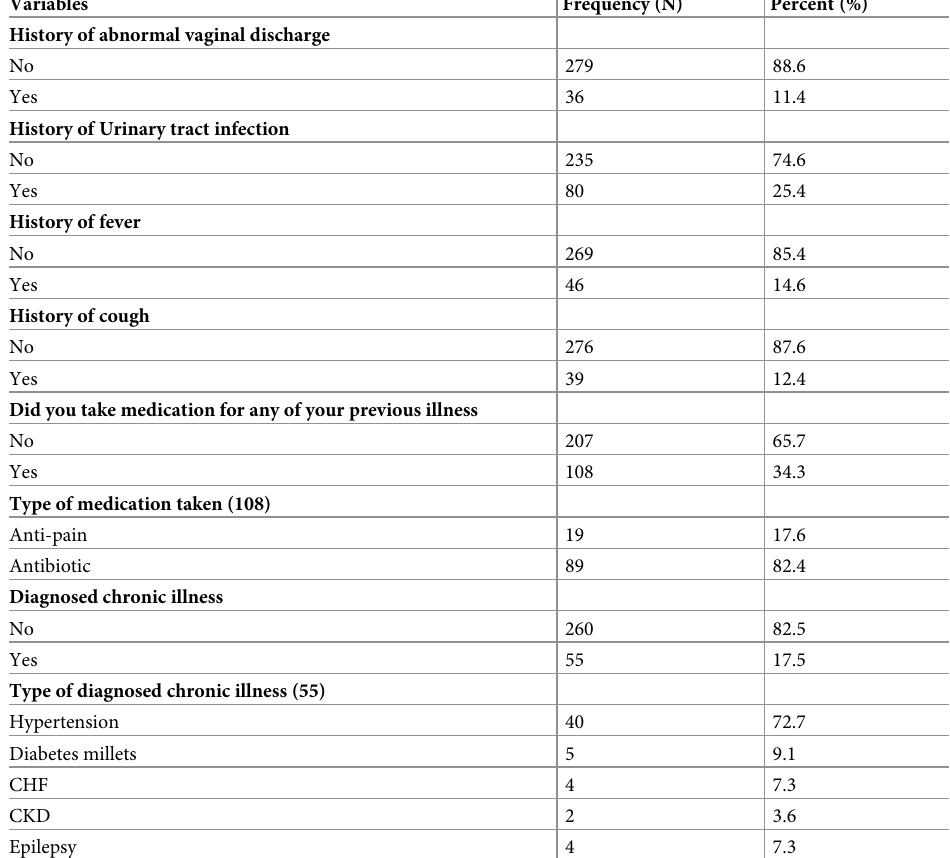
Table 3. History of medical illness and clinical related characteristics of PROM among pregnant women admitted to the maternity ward at Debre Markos Referral Hospital, 2019.